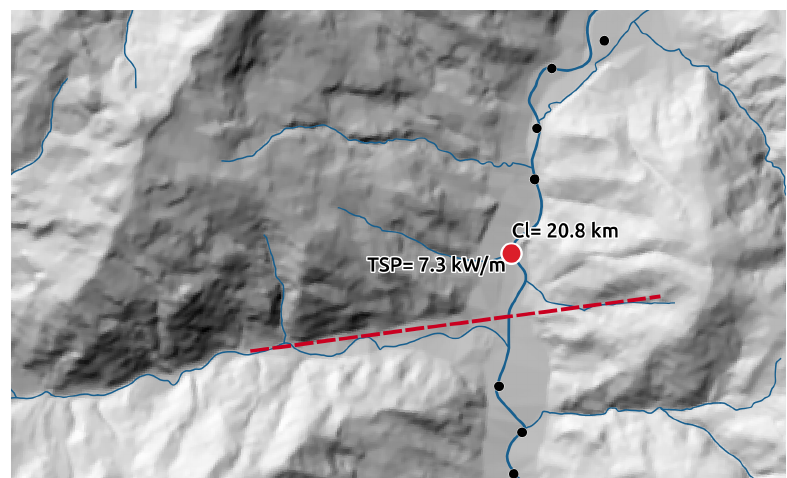
Figure 11. Peak #1 location. The presence of a fault (red dashed line) is highlighted by the alignment of the two tributaries on the right and left bank.